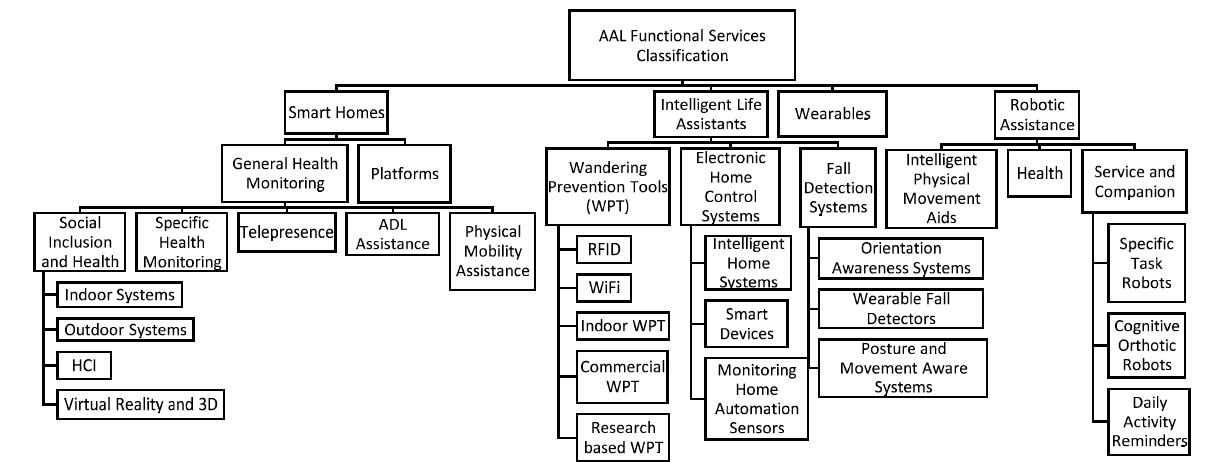
Figure 2. AAL functional services classification (adapted from [38] (p. 4)).